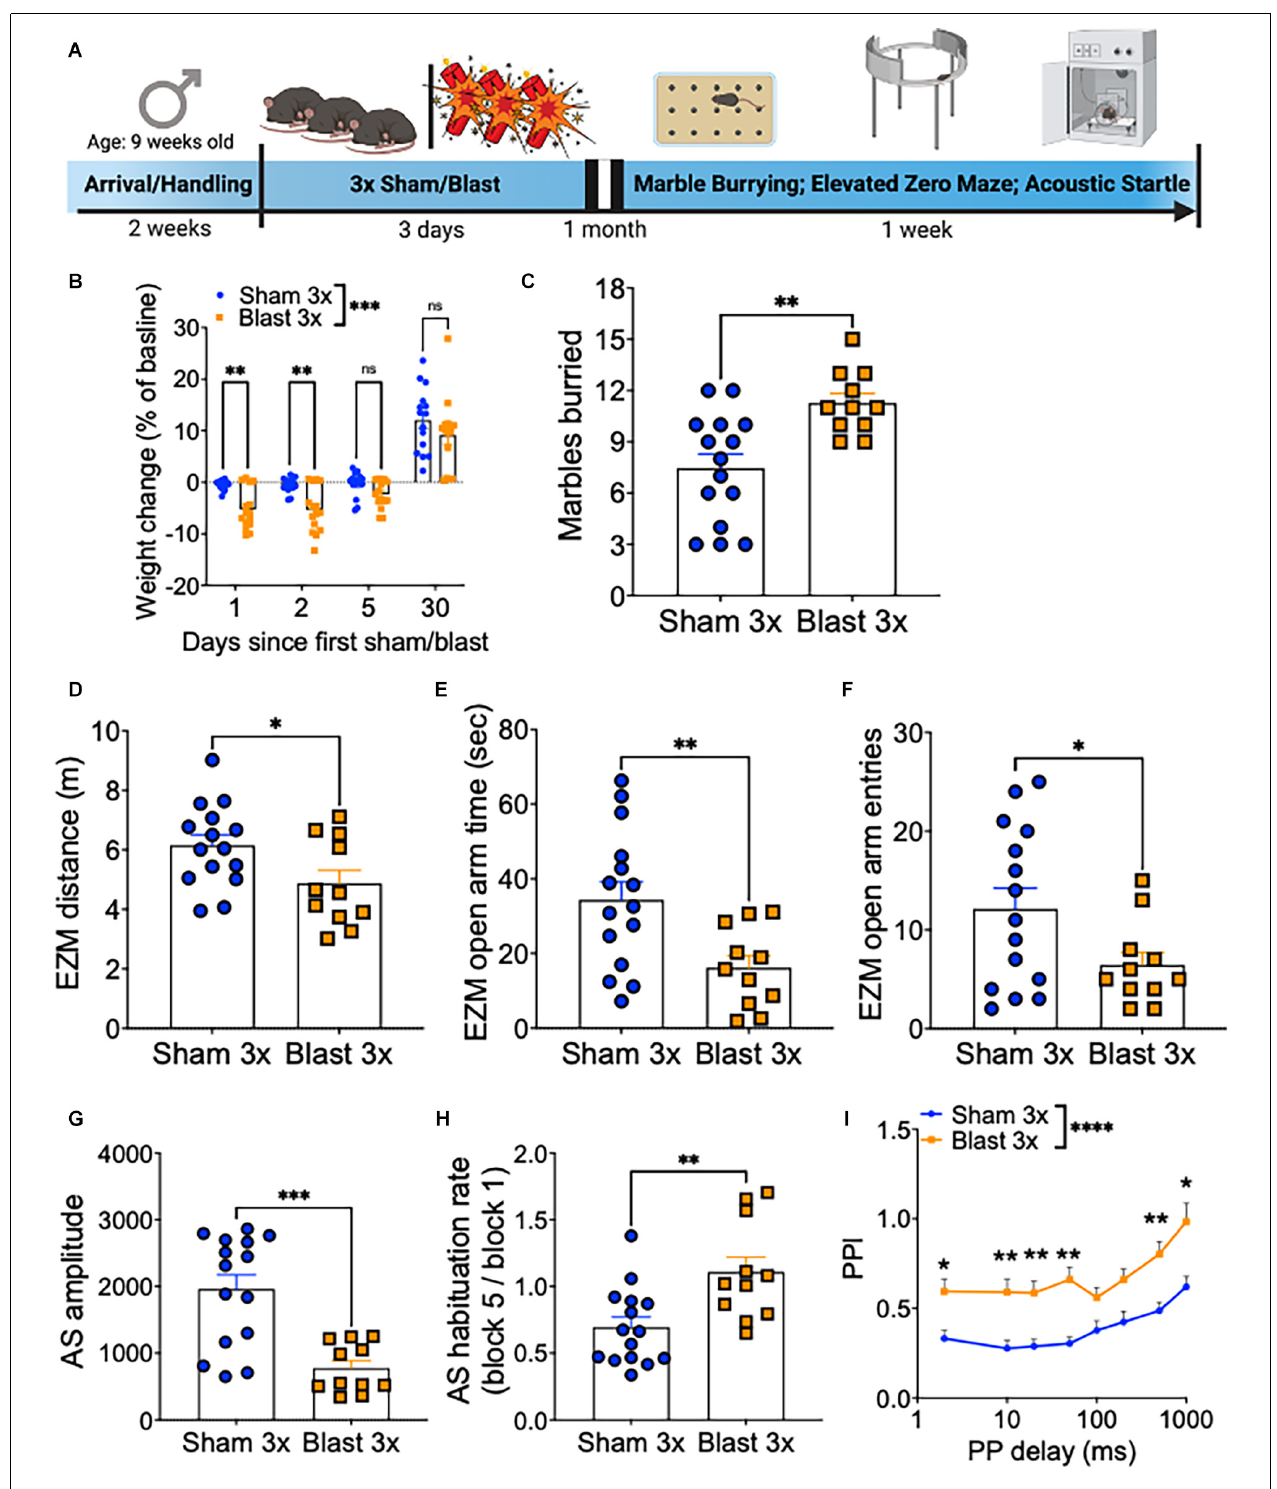
FIGURE 1 | Repetitive blast exposure increases behavioral indices of anxiety/compulsivity and hyperreactivity. (A) Timeline schematic. (B) Weight change as % baseline weight. (C) Number of marbles buried. (D) Distance traveled in the elevated zero maze. (E) Time spent in the open arm of the elevated zero maze. (F) Entries into the open arms of the elevated zero maze. (G) Raw acoustic startle amplitude. (H) Acoustic startle habituation rate. (I) Pre-pulse inhibition (PPI). Student’s t -test (C–H) , two-way RM ANOVA Bonferroni-Šídák post hoc (B,E) . * p ≤ 0.05, ** p ≤ 0.01, ∗∗∗ p ≤ 0.001, ∗∗∗∗ p ≤ 0.0001, ns, not significant. Values represent mean ±